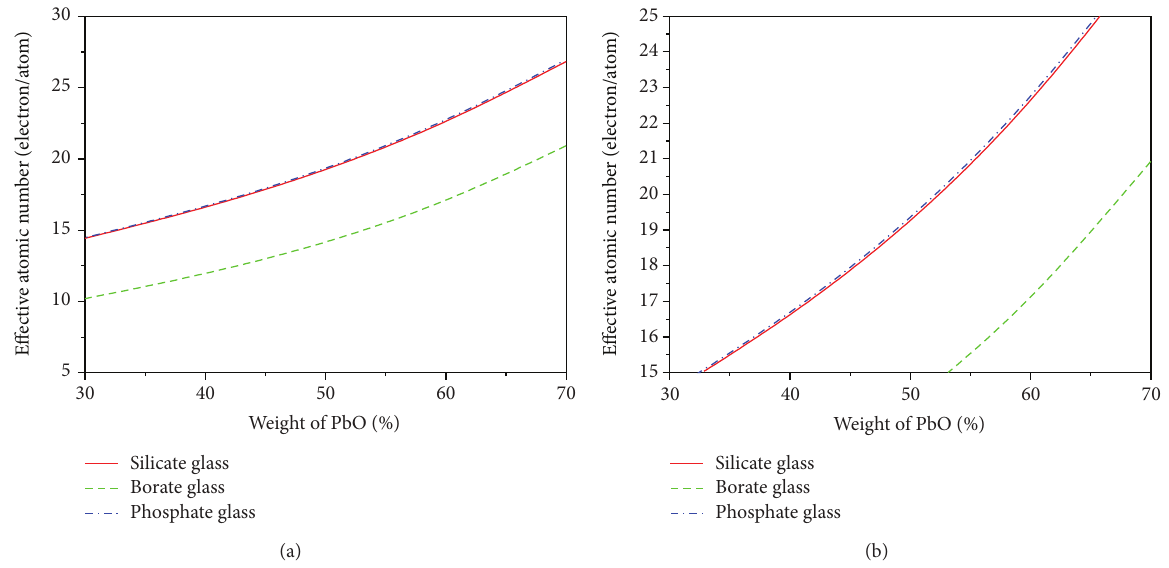
Figure 2: (a) The effective atomic numbers of PbO containing silicate, borate, and phosphate glass systems at 662 keV; (b) expansion view of (a).